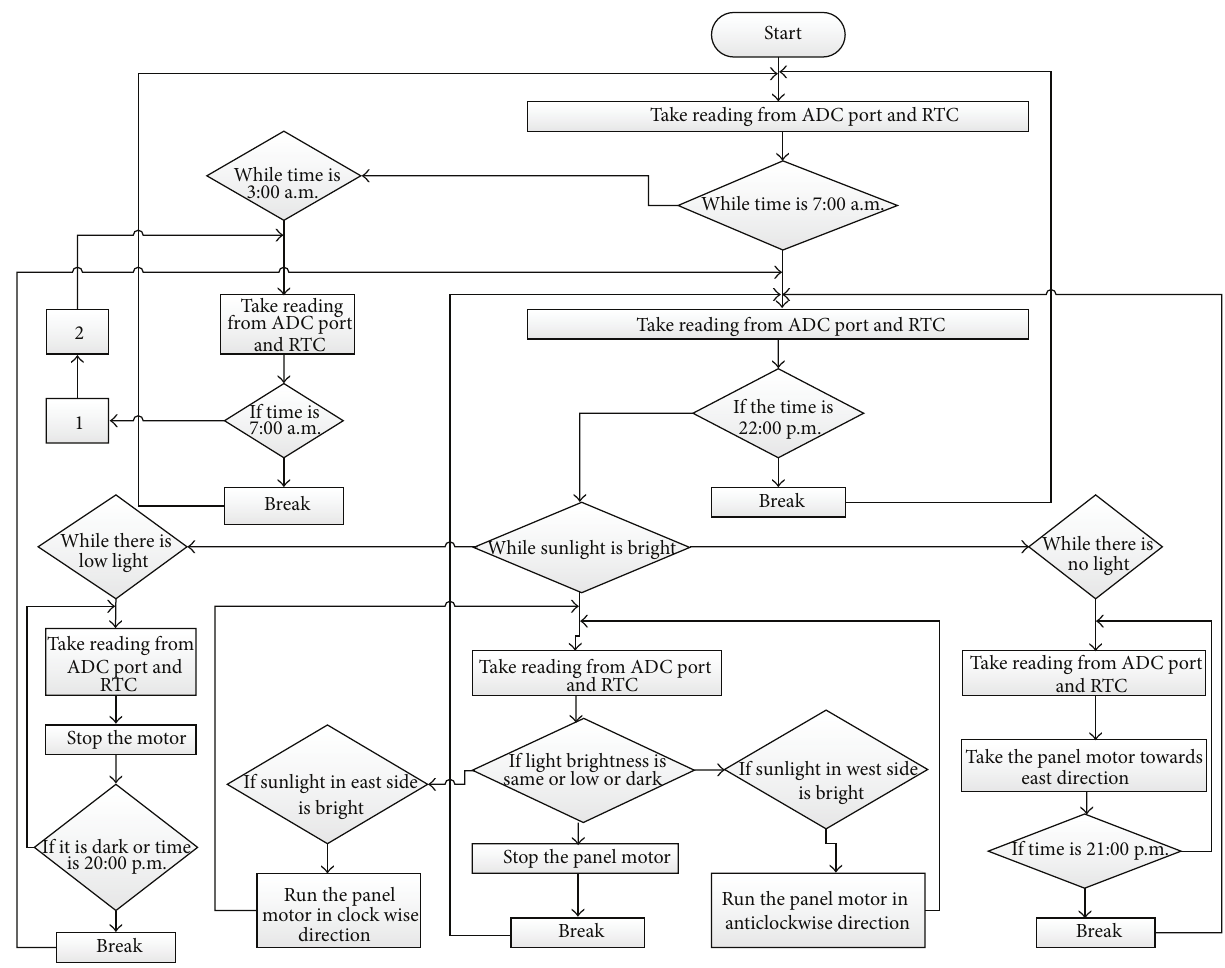
Figure 10: Main flowchart of microcontroller programming.